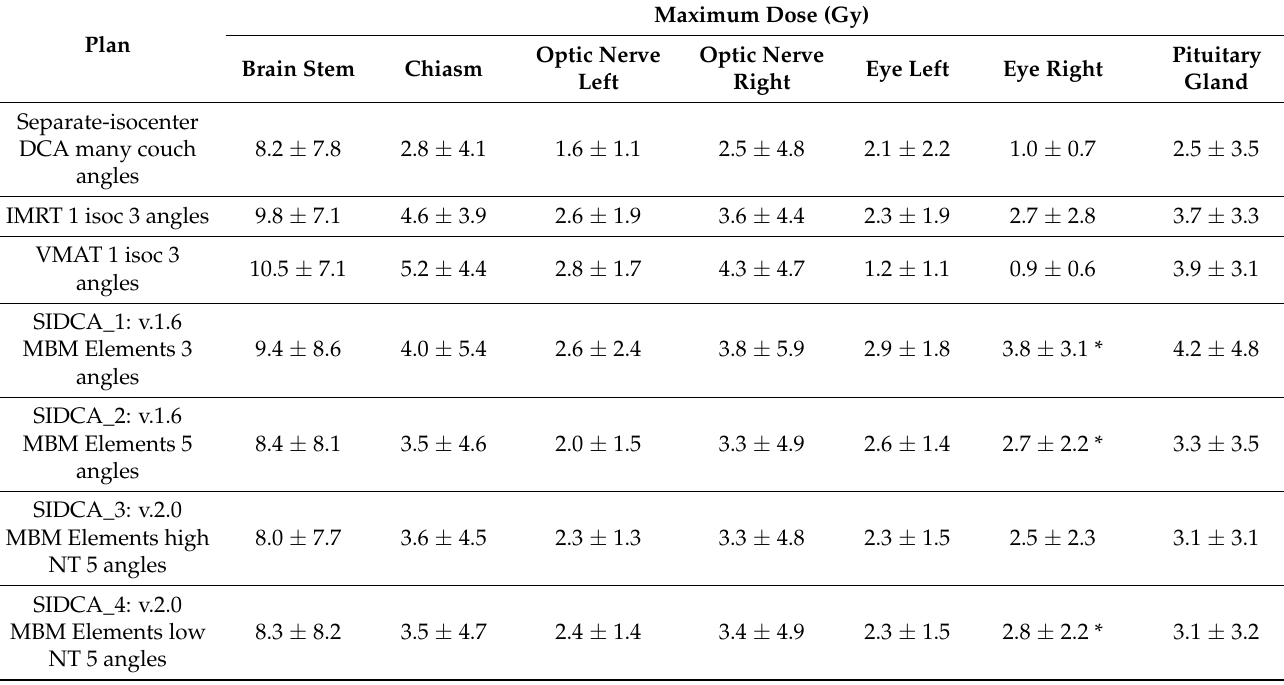
Table 3. The maximum dose to brain stem, chiasm, optic nerves (left and right), and eyes (left and right) averaged over twelve patients as mean ± 1SD. For all planning techniques, they were not significantly different from separate-isocenter (reference) planning ( p >